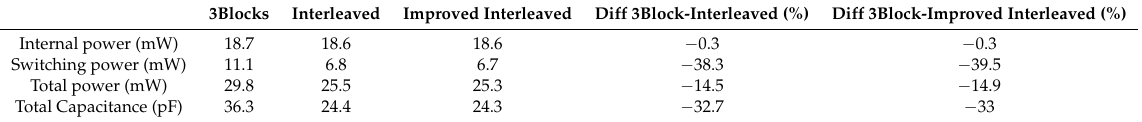
Table 1. Power consumption